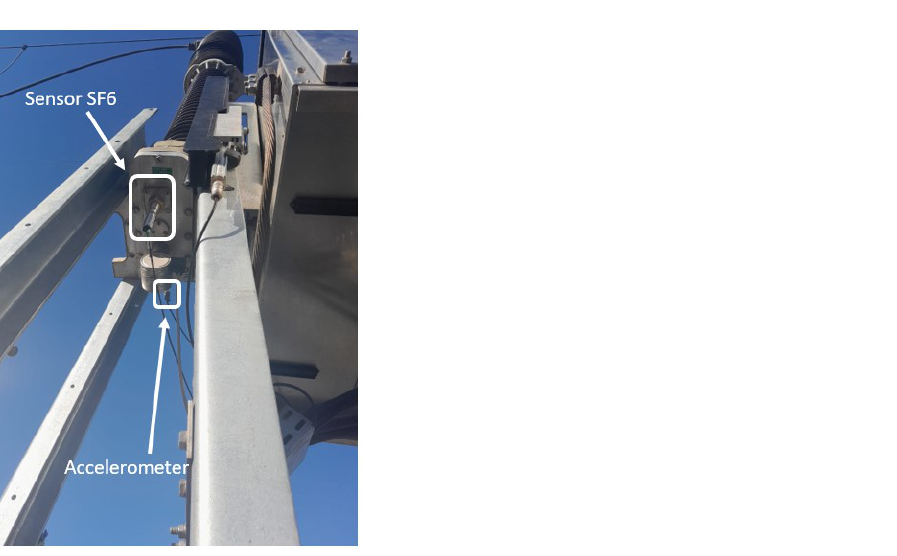
Figure 19. SF6 sensor and accelerometer installed in the pole crankcase.